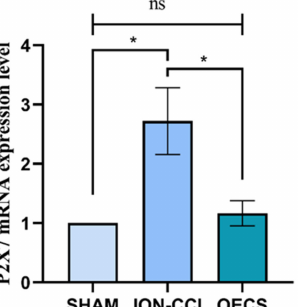
Figure 5. Changes of P2X7R mRNA level in TG. In this part, The expression level of P2X7R mRNA in each group was determined by the 2 − ∆∆ CT method. The expression of P2X7R mRNA in the TG was significantly different among the groups. The mRNA level of P2X7R in the ION-CCI group was significantly higher than that in the sham ( p < 0.05) and OEC ( p < 0.05) groups. After OEC transplantation, the mRNA level of P2X7R in the TG of the rats decreased significantly and was similar to that in the sham group ( p > 0.05). Data are expressed as mean ± SEM ( n = 4 per group, one-way analysis of variance followed by the least significant difference post hoc test). * Indicates p < 0.05 when comparing the sham and ION-CCI groups and * indicates p < 0.05 when comparing the ION-CCI and OEC groups. Ns. indicates p > 0.05 when comparing the sham and OEC groups. The OEC group was comprised of rats with ION-CCI that were treated with OECs. ION-CCI, chronic constrictive injury of infraorbital nerve; OEC, olfactory. ensheathing cell; SEM, standard error of the mean; TG, trigeminal